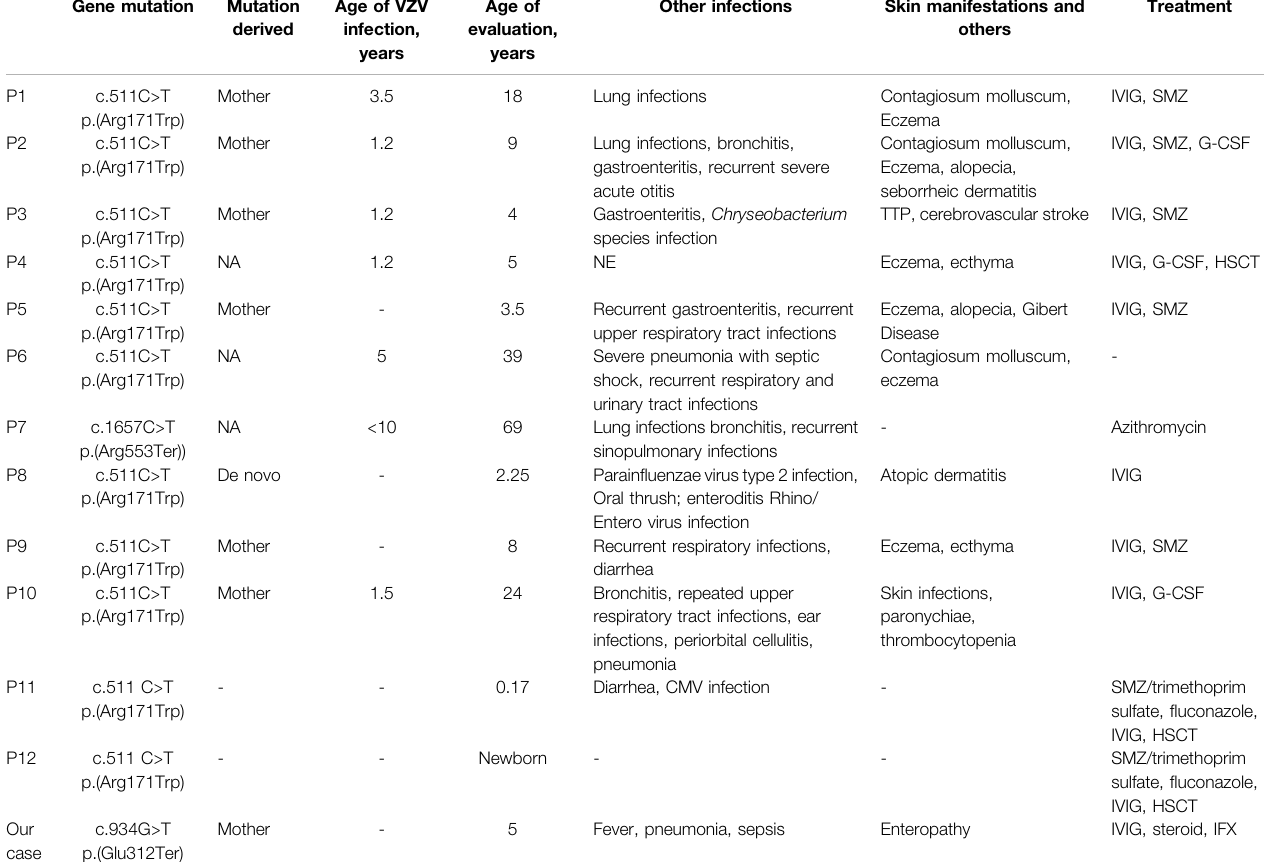
TABLE 1 | The clinical and genetic mutation features of those reported in literatures along with our case. Gene